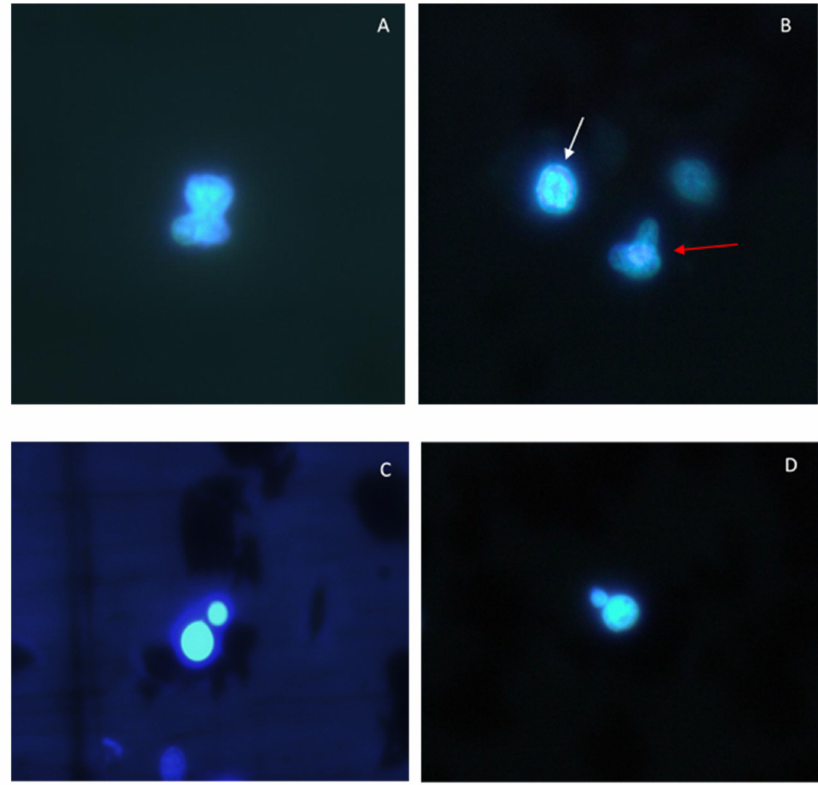
Figure 4. Chromosomal aberrations and micronuclei in R. philippinarum haemocytes following exposure to C6O4. ( A ) Eight-shaped nucleus. ( B ) Chromatin margination toward the nuclear membrane (white arrow) and multipolar cell (red arrow). ( C , D )